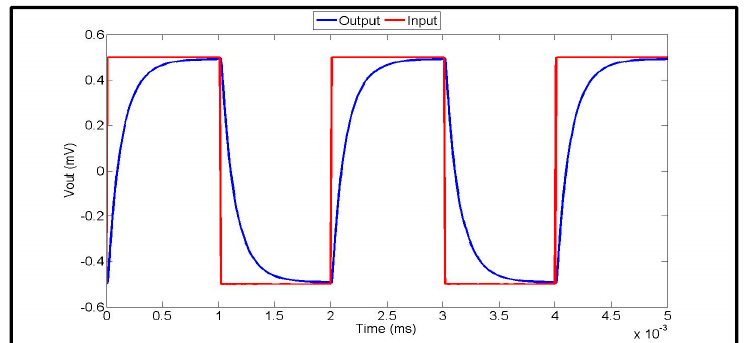
Figure 13. Slew Rate.